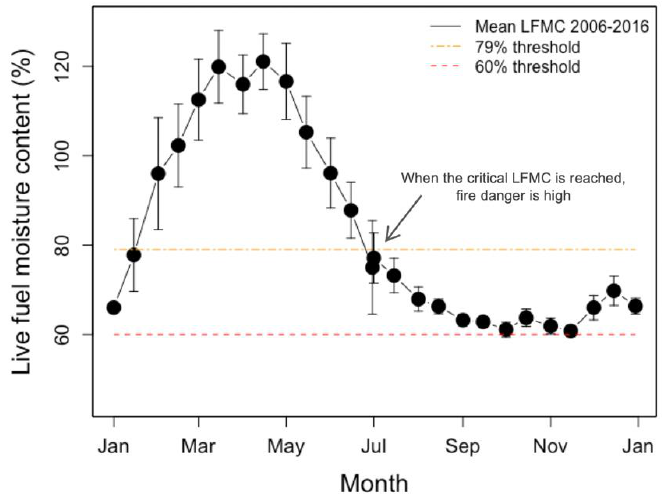
Figure1. Meanlivefuelmoisturecontent( LFMC ) ± standard error, measured for Adenostoma fasciculatum at Stunt Ranch Santa Monica Mountains Research Reserve from 2006–2016, represented by the solid black symbols and line. The red dashed line indicates the 60% critical LFMC threshold used by local fire departments, while the orange dash-dotted line indicates the 79% threshold from Dennison and Moritz (2009).